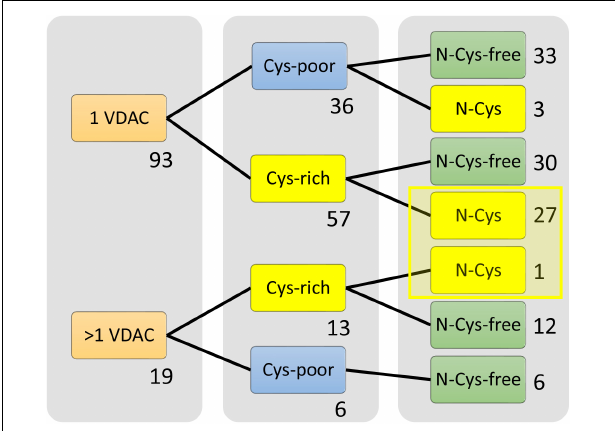
FIGURE 2 | Selection of organisms that possess the only redox-sensitive VDAC (rsVDAC) variant in mitochondria. The analysis indicates the number of cysteine residues and their location in the VDAC secondary structure, as well as the absence or presence of VDAC paralogs, that is, the presence of only one VDAC variant (1 VDAC) or VDAC paralogs ( > 1 VDAC). Cys-poor: a set of organisms in which only one VDAC variant or at least one VDAC paralog (if present) has fewer than two cysteine residues in the primary structure; Cys-rich: a set of organisms in which only one VDAC variant or all VDAC paralogs (if present) have more than one cysteine residue in the primary structure; N- Cys-free: a set of organisms that have at least one VDAC variant with no N-terminal cysteine residue; rsVDAC, redox-sensitive VDAC.